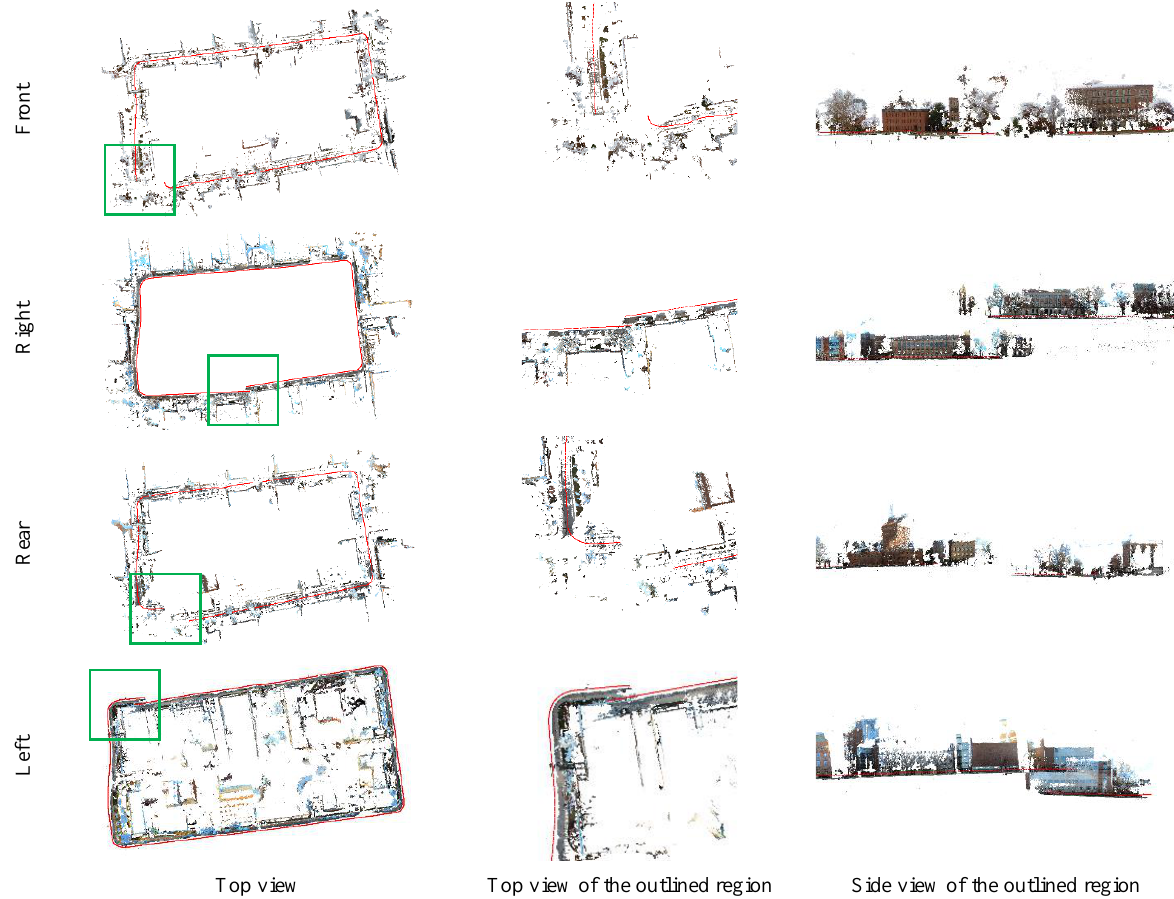
Top view Top view of the outlined region Side view of the outlined region Figure 3 . Visual results for dense reconstruction of four mounting configurations of cameras. The green rectangles outline the region with large drift. The estimated poses of cameras are shown in red.